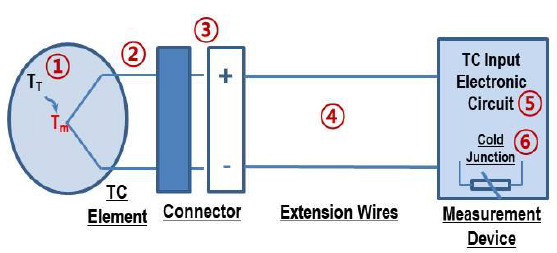
Fig. 2 Error sources in a Thermocouple connection